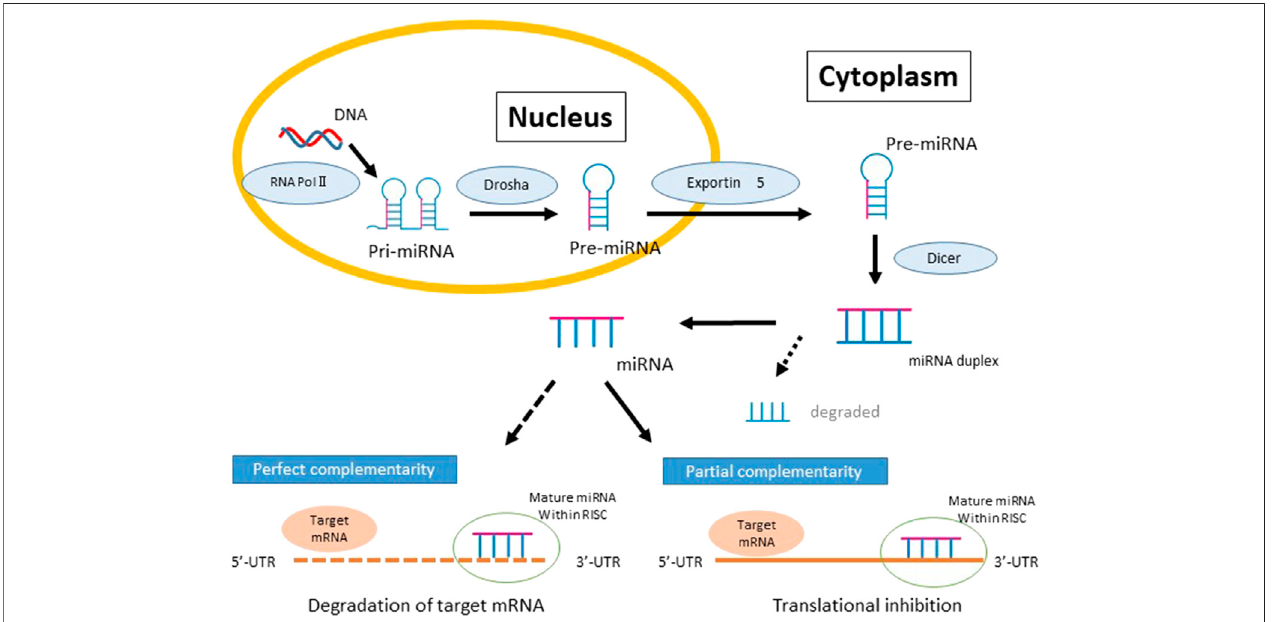
FIGURE 1 | The biogenesis and function of MicroRNAs (miRNA) and the repression of gene expression. Biosynthesis of miRNAs begins in the nucleus and RNA polymerase II-dependent transcription produces capped polyadenylated transcripts known as primary miRNAs (pri-miRNAs). Pri-miRNA is processed by the RNase III endonuclease, Drosha, into a stem-loop structure known as the precursor miRNA(pre-miRNA). Pre-miRNA is transported from the nucleus to the cytosolby Exportin 5 and further processed by the second RNase III, Dicer, to generate miRNA duplexes. Posttranscriptional gene silencing occurs when the mature miRNA is then loaded into the miRNA-induced silencing complex and binds to the 3 ′ UTR of target mRNAs with either complete or partial complementarity.